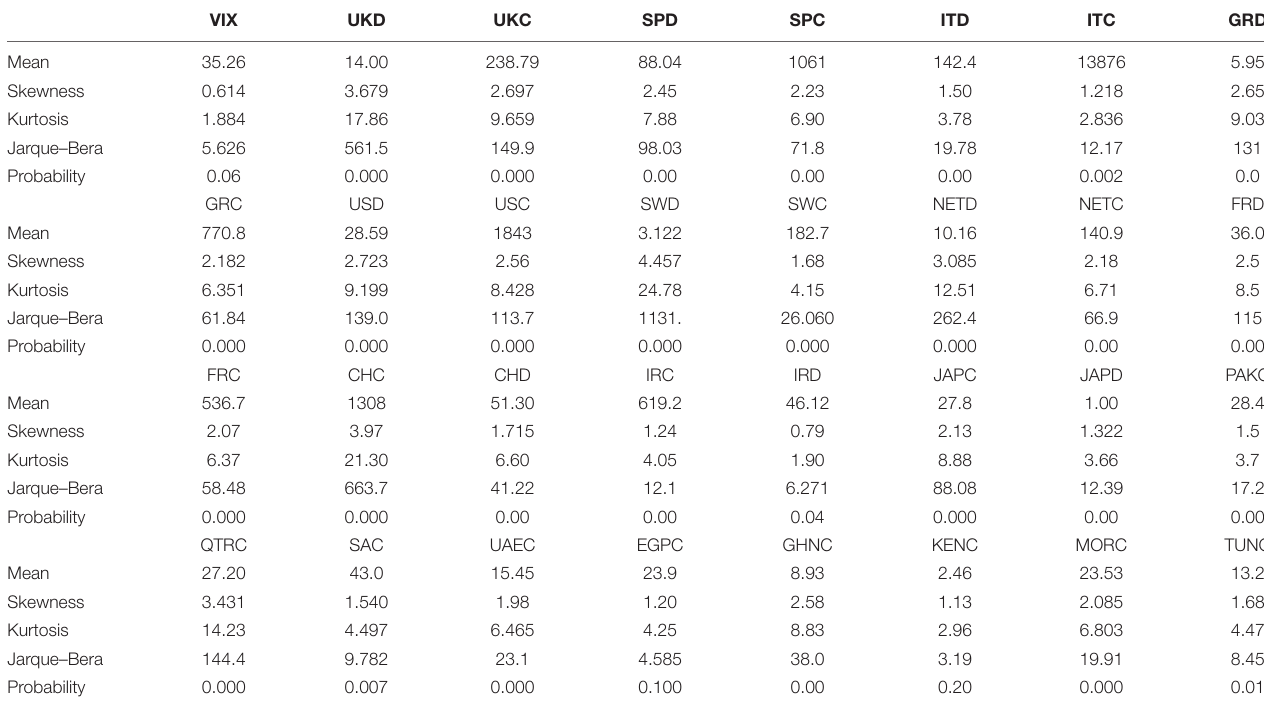
TABLE 1 | Descriptive statistics of study